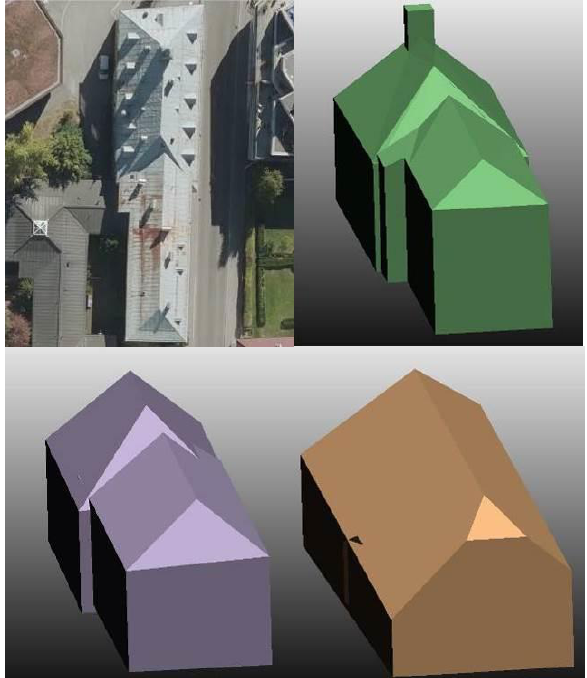
Figure 6. Comparison of orthophoto, reference model (green), LOD2 model nadir + oblique (lilac) and LOD2 model nadir-only (orange). LOD2 does not include structures on the